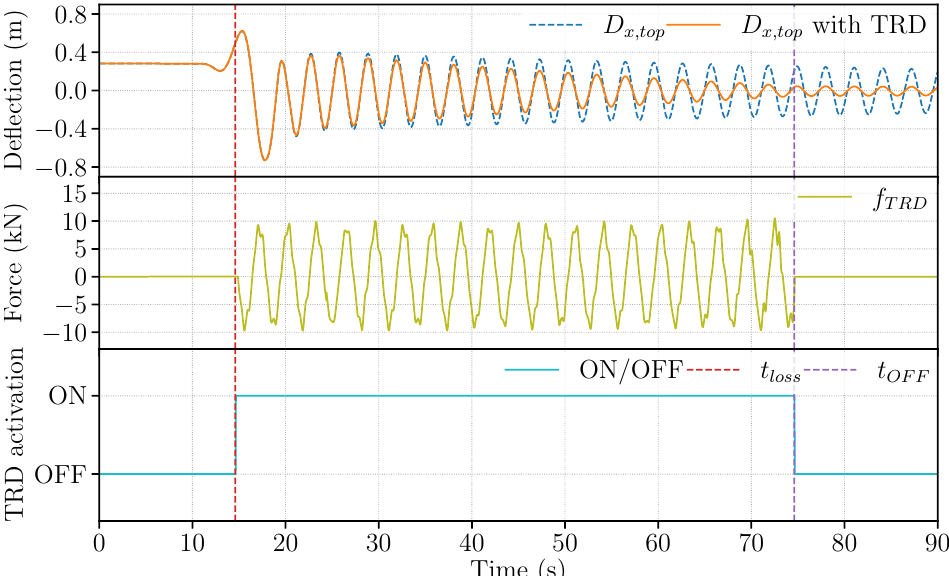
Figure A3. Tower-top fore-aft deflection and status of TRD in EOG with grid loss at V rate + 2 (the time dependency is omitted in legend).